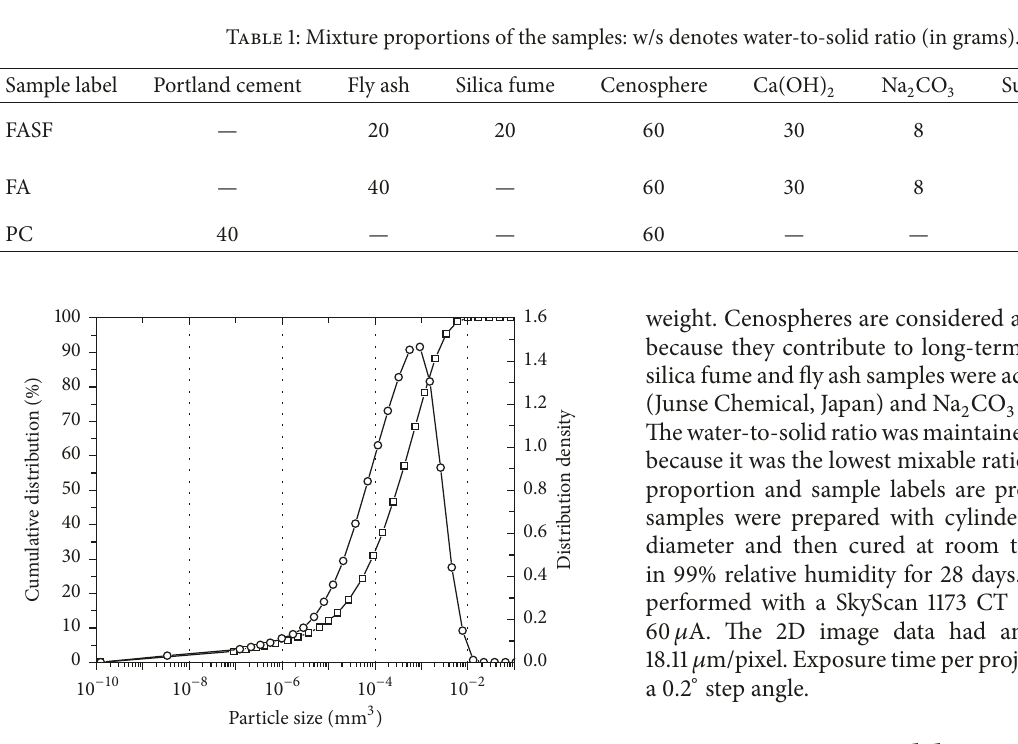
Figure 1: Particle size distribution of cenospheres